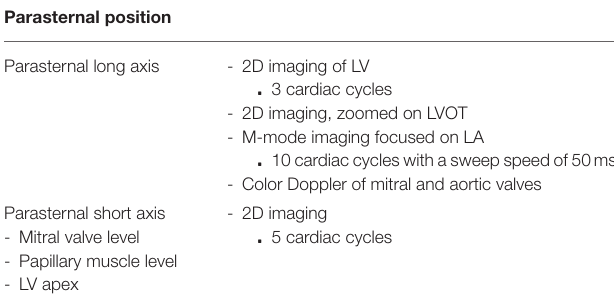
TABLE 1 | SABRE echocardiographic imaging protocol. Parasternal